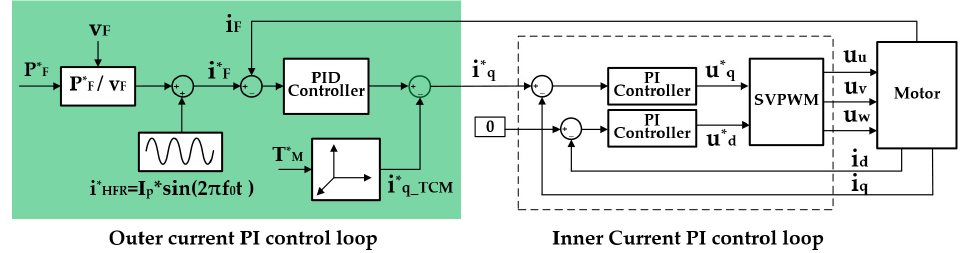
Figure 7. Realization of HFR perturbation current based on the proposed control